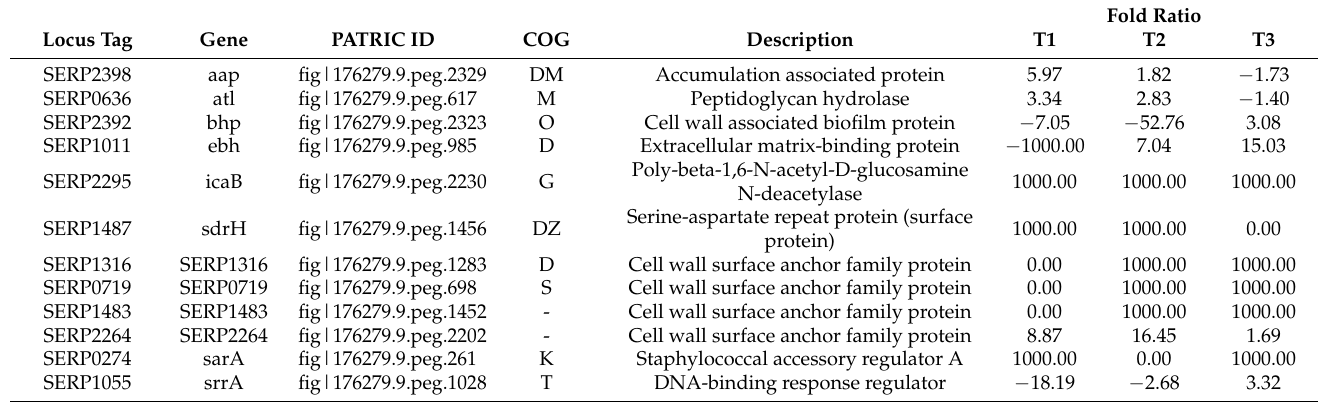
Table 1. Differentially expressed proteins associated with biofilms.